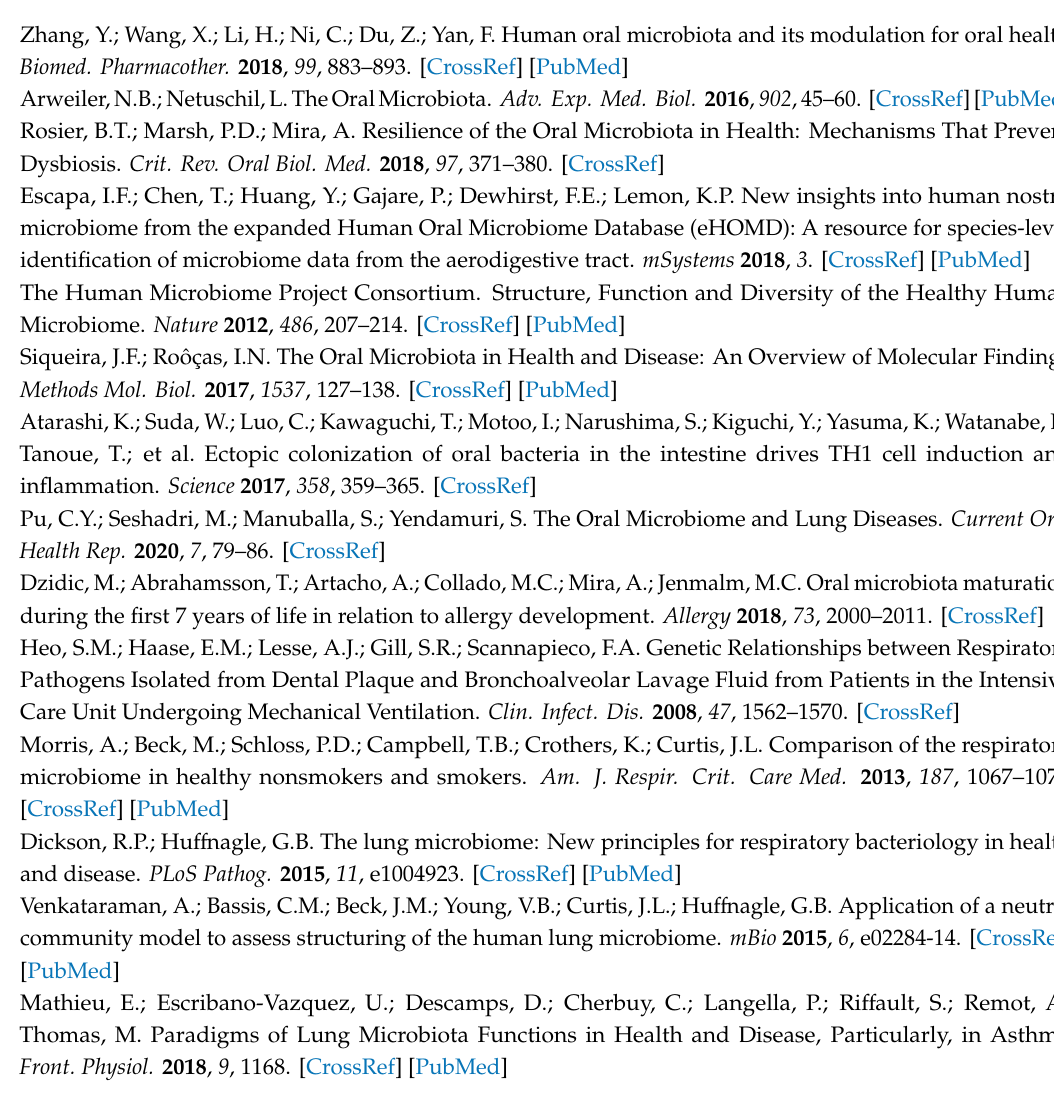
Figure S1: Cytokines and chemokines profiling of the BEAS-2B cells in response to bacterial incubation. Figure S2: Cytotoxicity induced by early life oral bacteria on BEAS-2B cells after 6 h treatment. Table S1: Fold changes for each strain and for each gene presented in Table